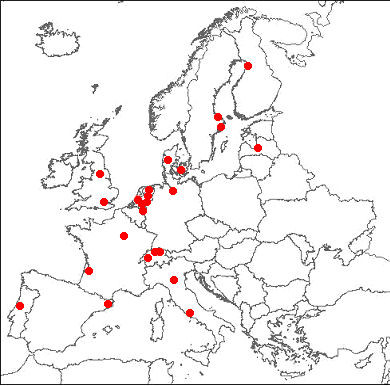
European participating centers in the delphi trial.